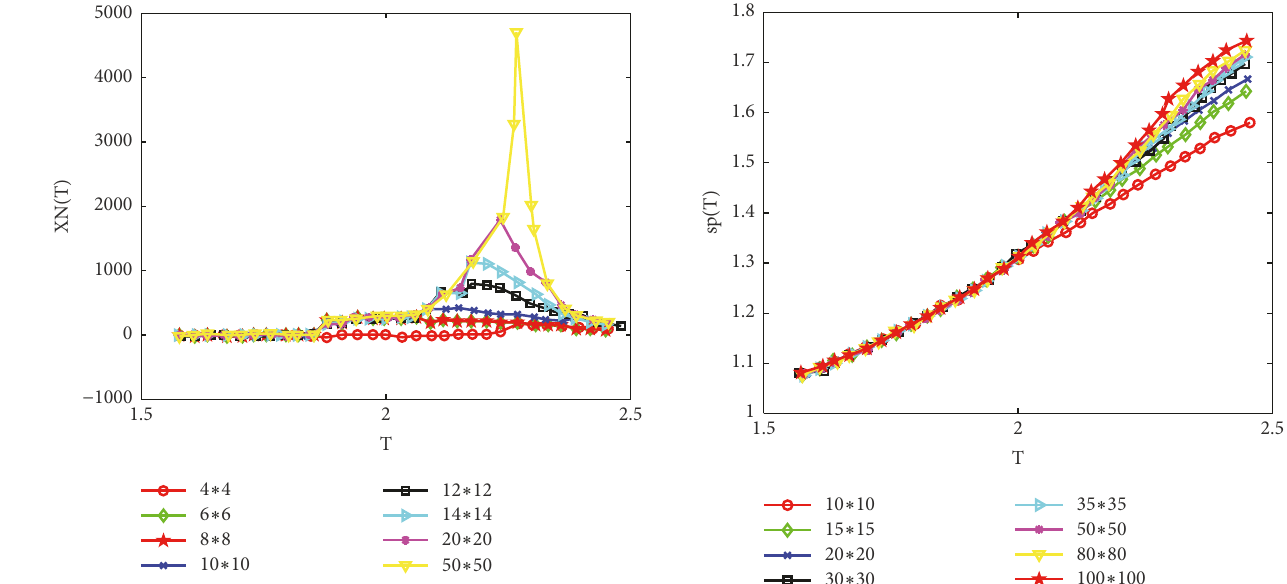
Figure 3: Variation of von Neumann entropy 𝑆 𝑝 (𝑇) of different systems with temperature 𝑇 .